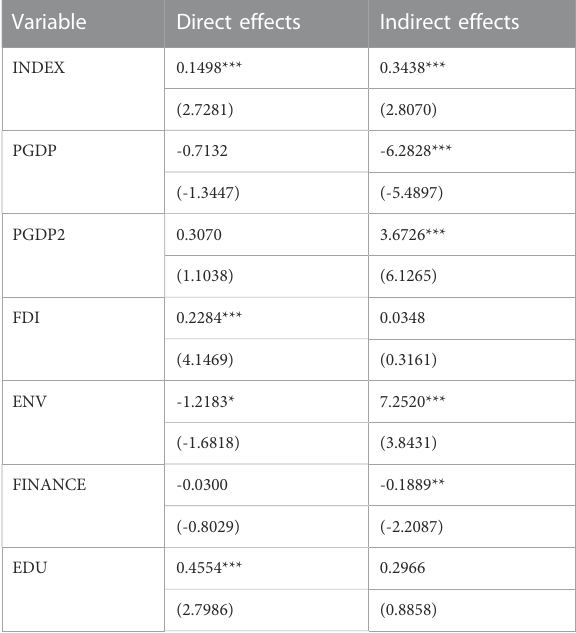
TABLE 5 Spatial effect decomposition.